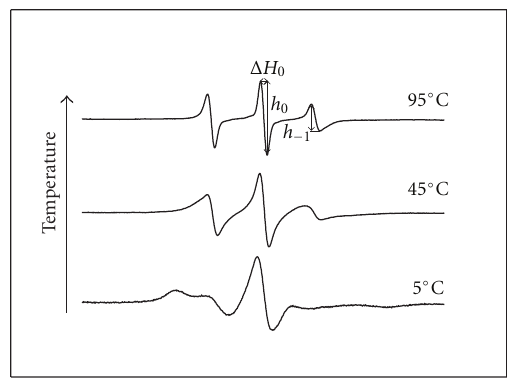
Figure 6: Representative EPR spectra of MeFASL(10,3) in the membrane of the SUV archaeosomes at pH 7.0 prepared from the PLMF isolated from A. pernix grown at pH